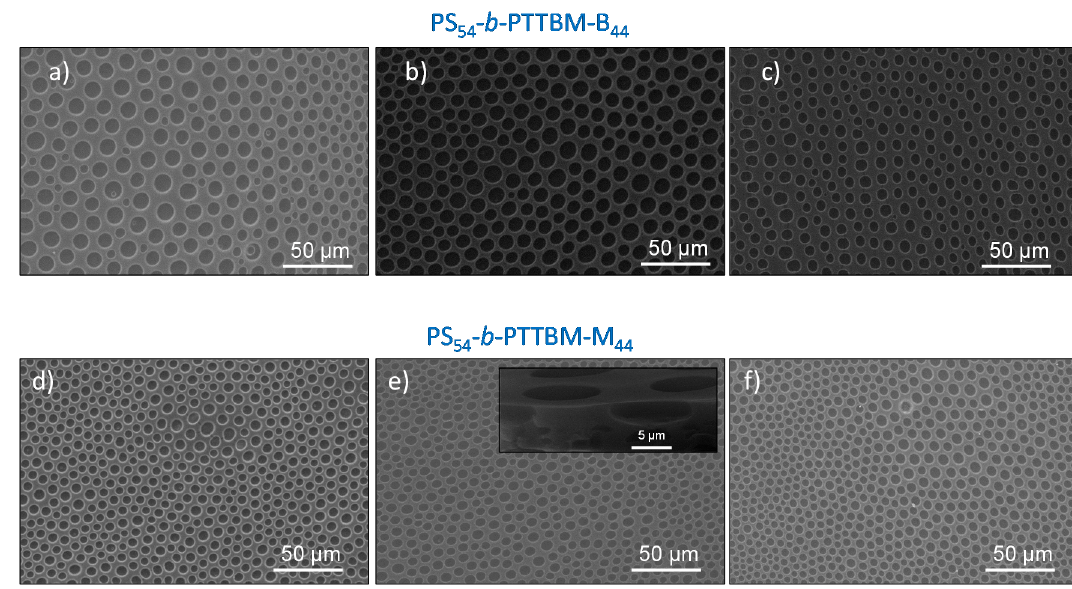
Figure 2. SEM micrographs of films obtained at 70% relative humidity composed of PS/PS 54 - b -PTTBM-B 44 blends: ( a ) 97/3 wt %; ( b ) 94/6 wt %; ( c ) 91/9 wt %; and PS/ PS 54 - b -PTTBM-M 44 blends: ( d ) 97/3 wt %; ( e ) 94/6 wt % (inset: cross-section); ( f ) 91/9 wt %. Table 1. Average pore diameter ± SD (standard deviation), conformational entropy (S), and roughness factor (r f ) of porous films containing variable content of the cationic copolymers PS 54 - b -PTTBM-B 44 and PS 54 - b -PTTBM-M 44 .